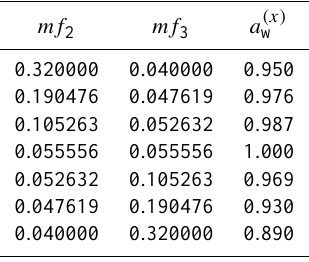
Table A5. Bulk water activity measurements of the system water